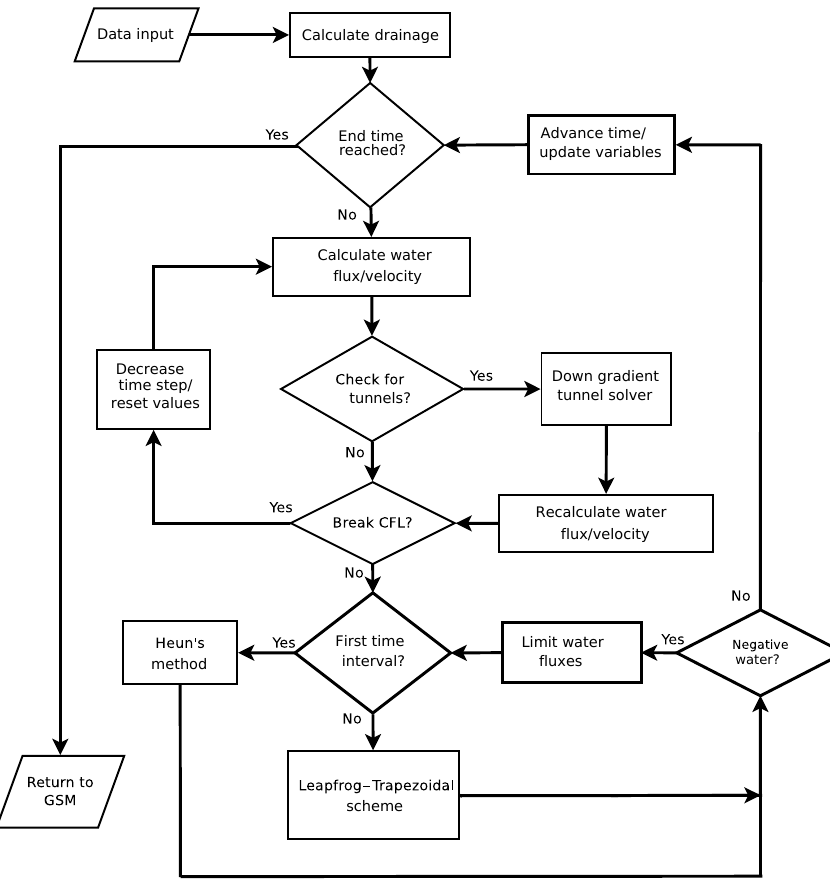
Figure A2. Hydrology model flow chart highlighting the processes involved in simulating basal water